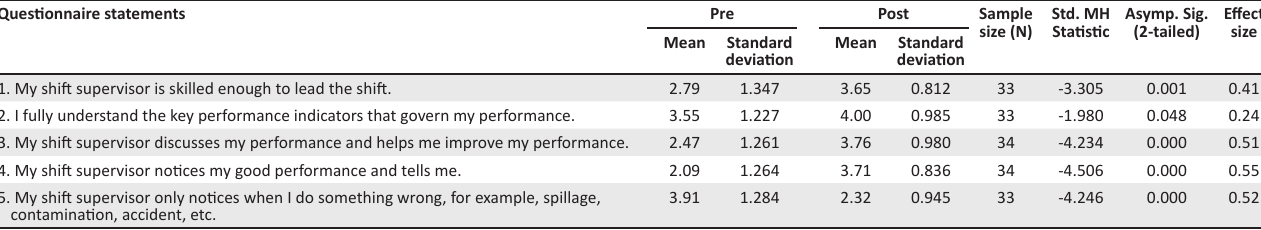
TABLE 1: Performance of transport supervisors as perceived by bulk truck drivers. Questionnaire